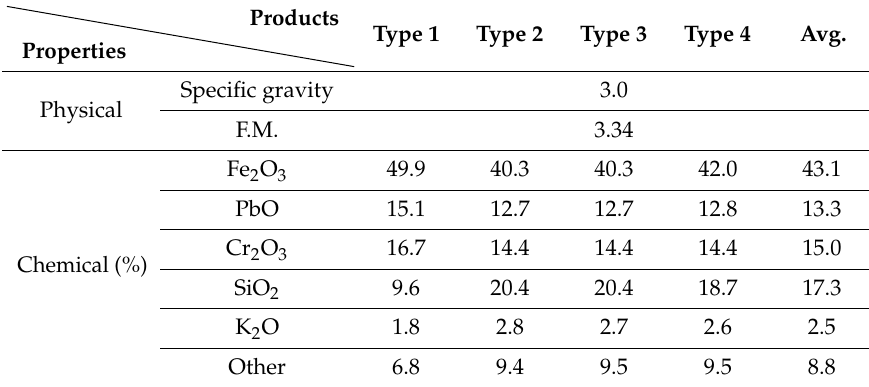
Table 2. Physical and chemical compositions of heavyweight waste glass.